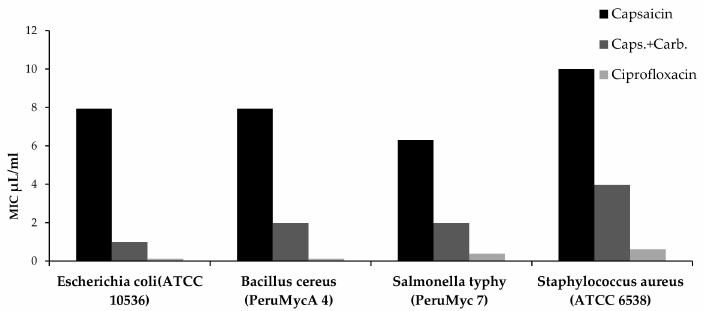
Figure 6. Bacterial Minimum Inhibitory Concentration (MIC) µ L/mL of Capsaicin from Carbopol- based